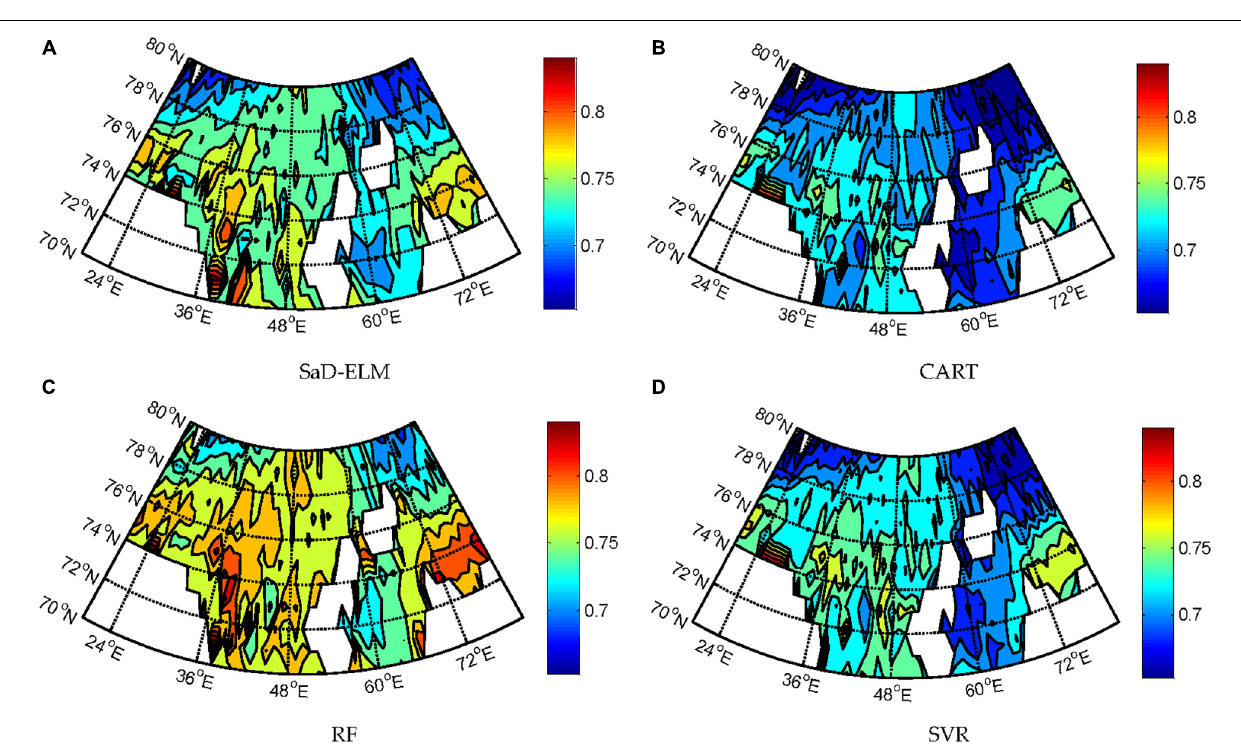
Frontiers in Marine Science |